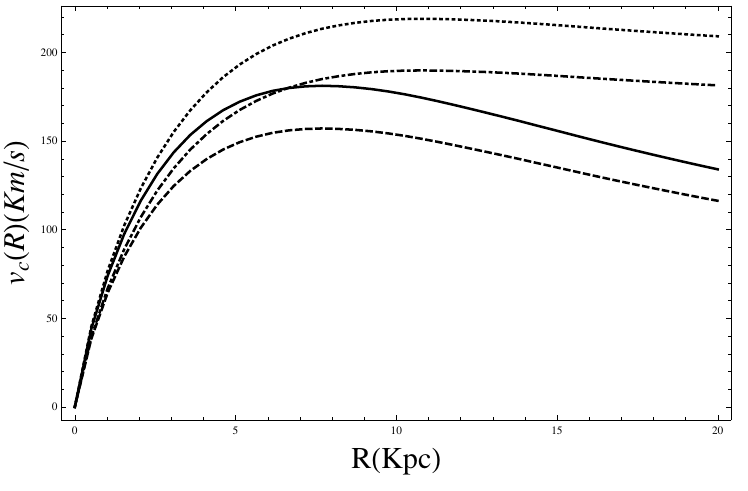
Table 1. Parameters of models Equation (88). The unity of mass is 10 10 M